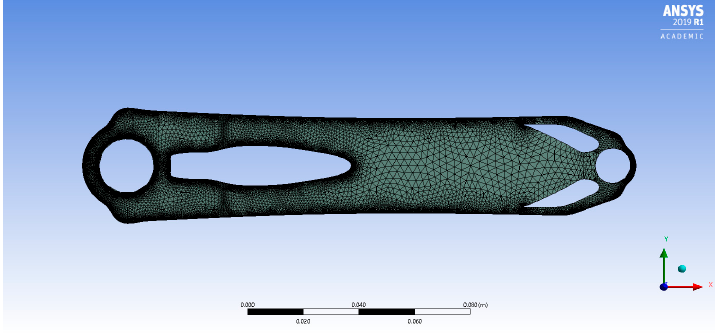
Figure 8. The final geometry of the topology optimized design.